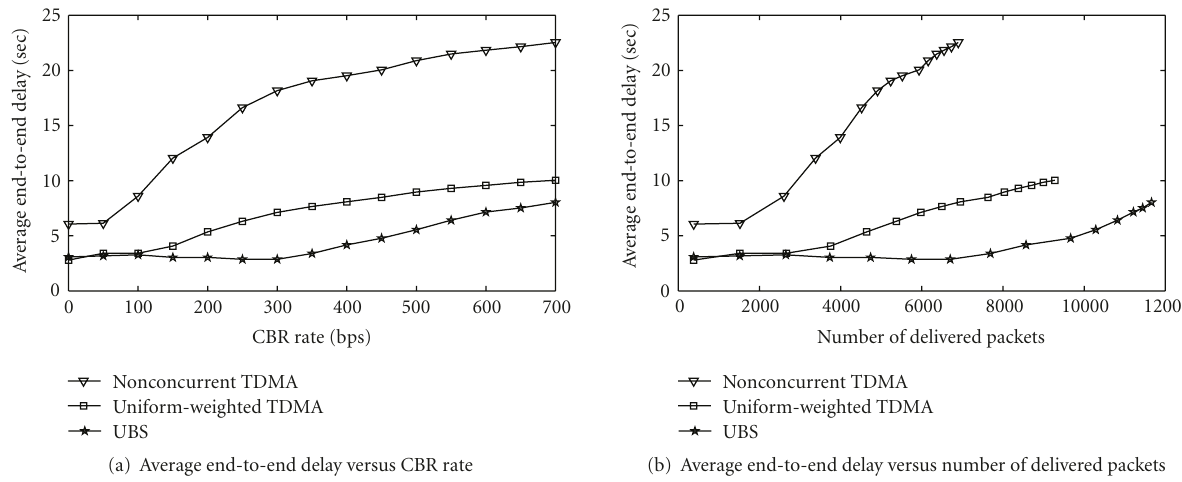
Figure 6: End-to-end packet delays in uniform tra ffi c scenarios averaged over 10 di ff erent 20-node network topologies.